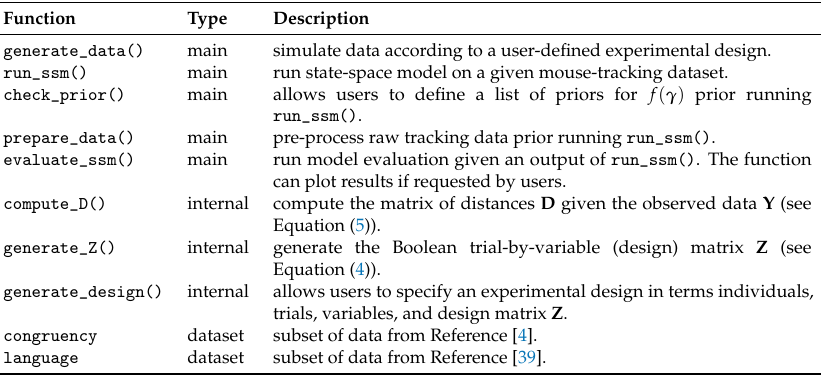
Table 1. Overview of the contents of ssMousetrack